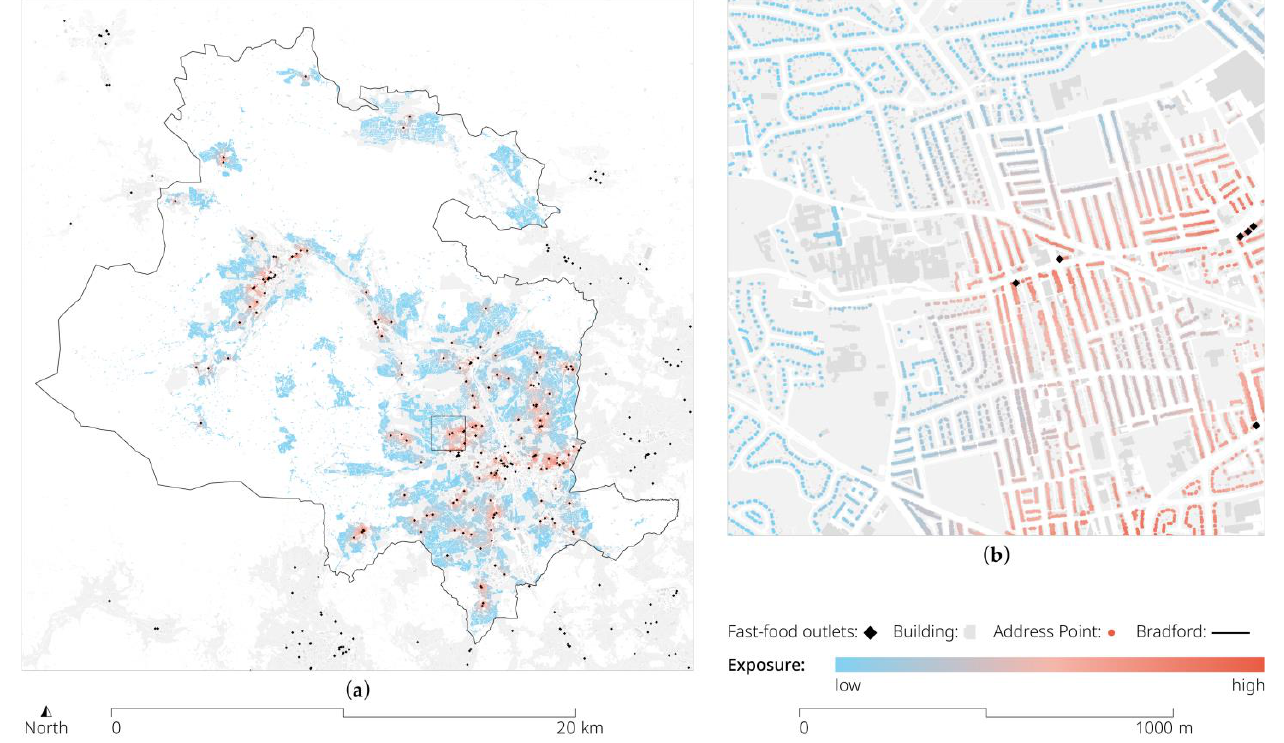
Figure 4. Visualisation of fast-food exposure measure showing distance decay weighted counts: ( a ) for the entire metropolitan district of Bradford; ( b ) detail zoom-in on Toller ward illustrating the address-level variation in the exposure measurement. © OS and Crown copyright 2022. Table 2. Selection of exemplary EIs from each of the 11 domains (Roman numerals match Table